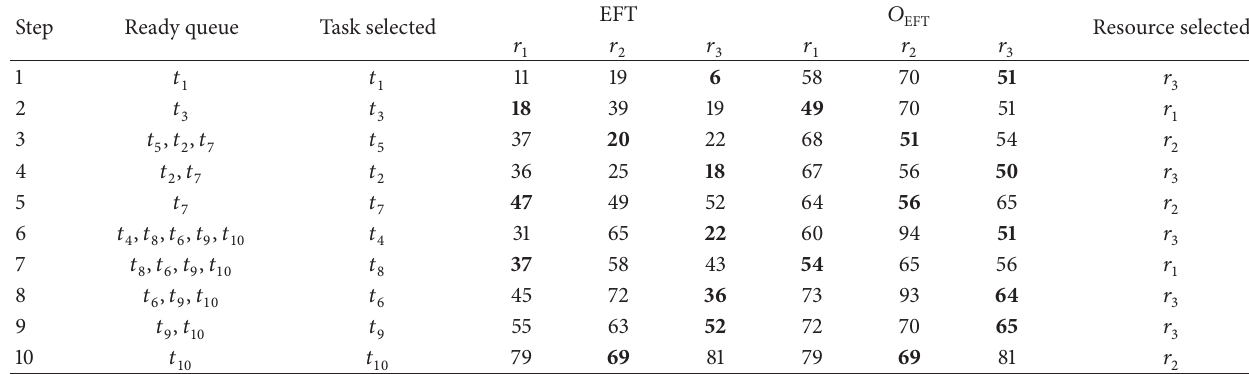
Table 4: Schedule produced by the HCPPEFT algorithm in each iteration.